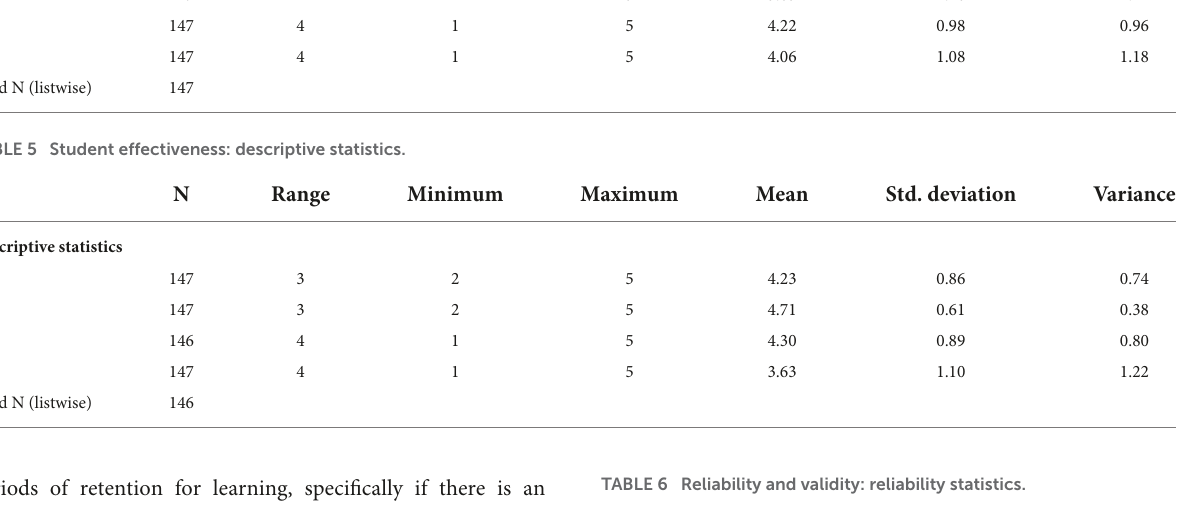
TABLE 6 Reliability and validity: reliability